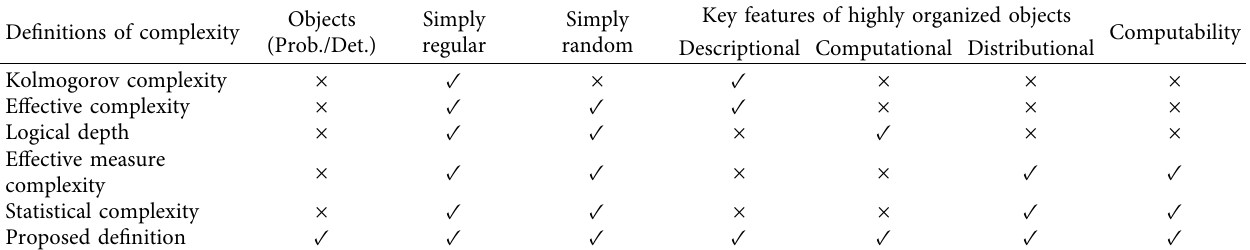
Table 1: Comparison of the proposed definition with the existing ones regarding criteria.